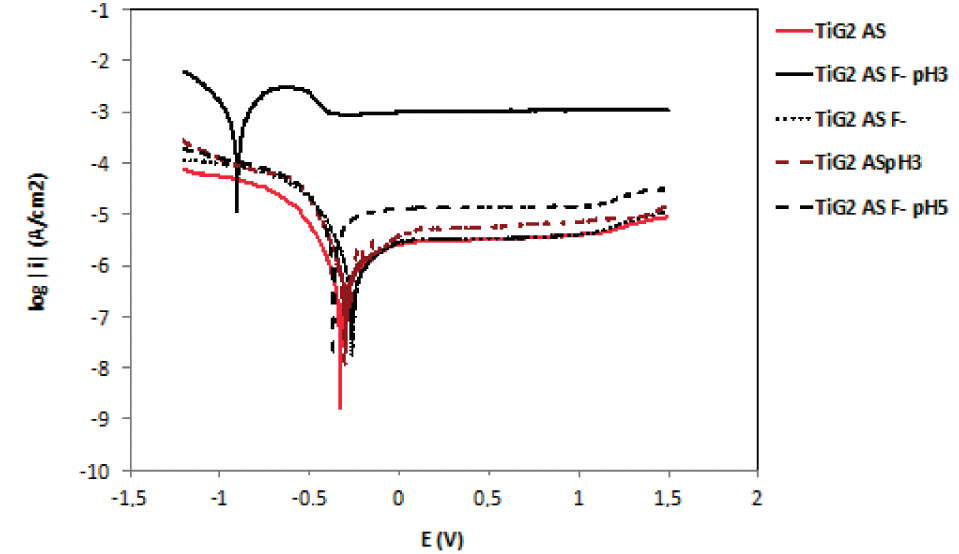
Figure 8. Potentiodynamic curves of TiG2 in different fluoride concentration medium and